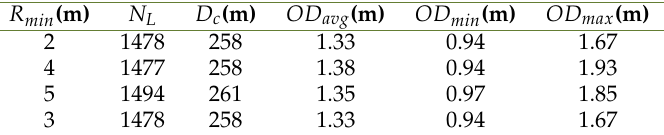
Table 2. Performance data with lookahead